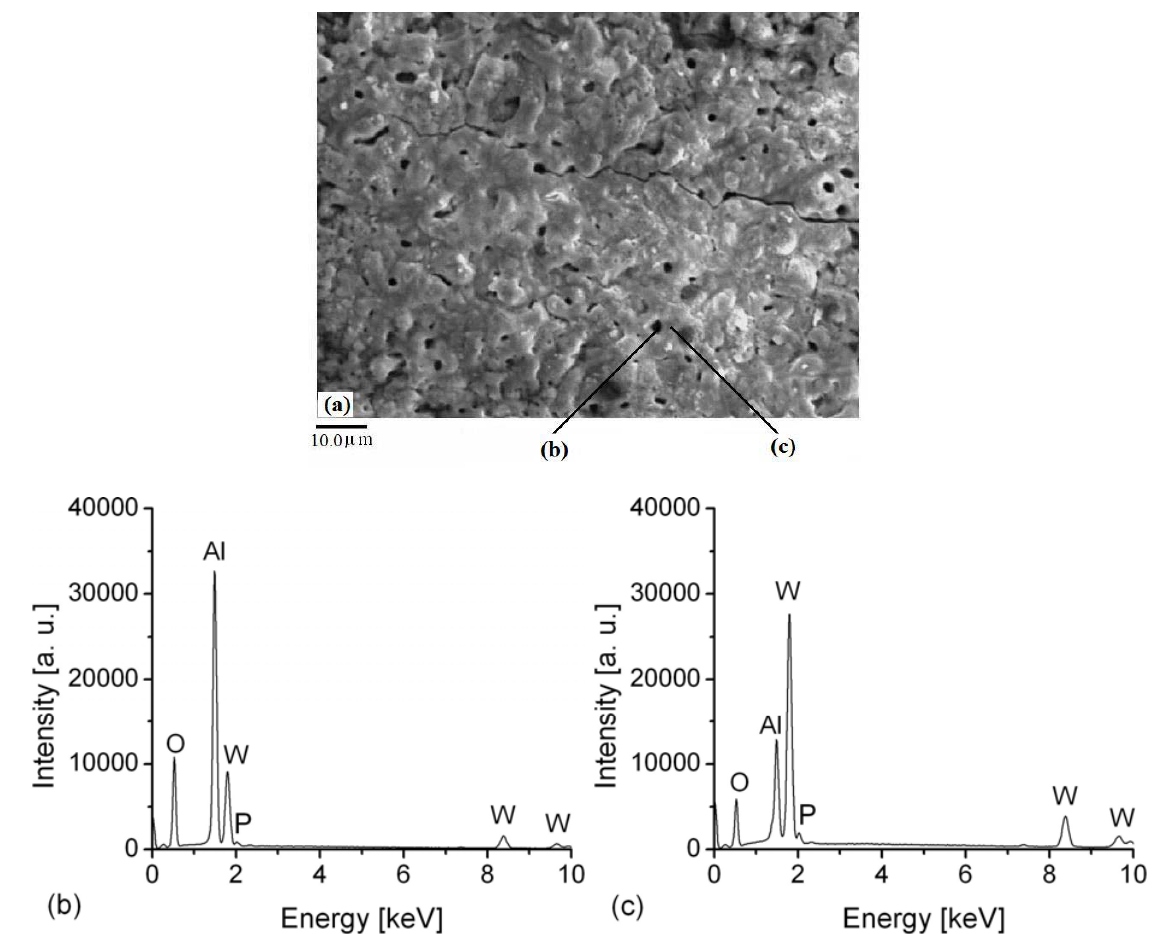
Figure 2. (a) SEM image of microarc oxidation coating treated for 30 min; (b) EDS spectrum recorded in discharge channel; (c) EDS spectrum recorded around discharge